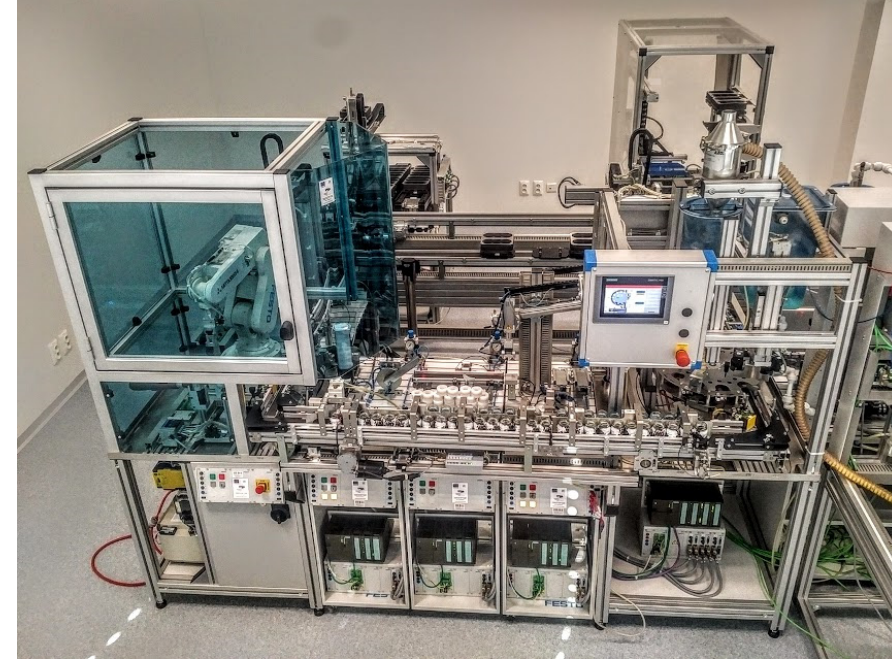
Figure 17. The model of production line used for proposed IIoT device testing.